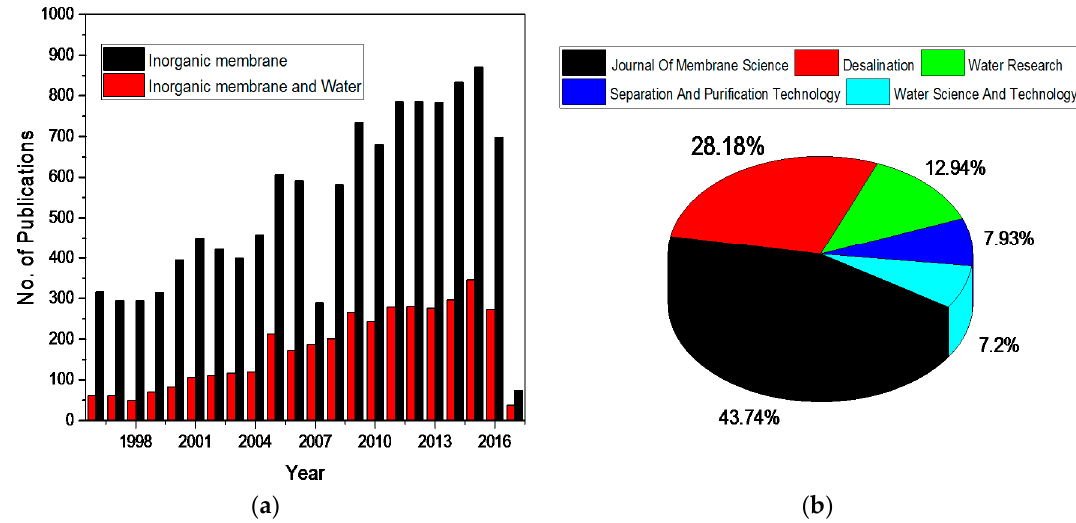
Figure 1. ( a ) The total number of publications on inorganic membranes in the literature according to Scopus database and ( b ) distribution of papers in the corresponding journals.